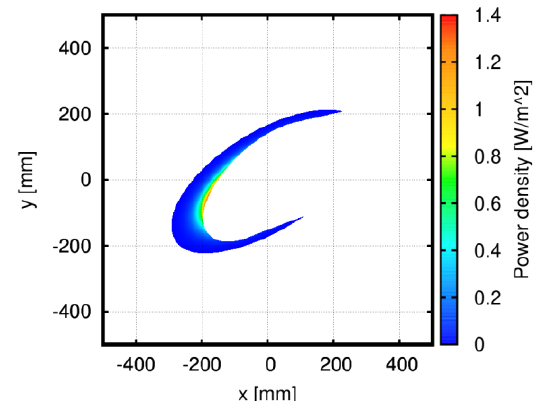
Fig. 12. Spill-over power of the beam U1 in the plane of the mirror UA.